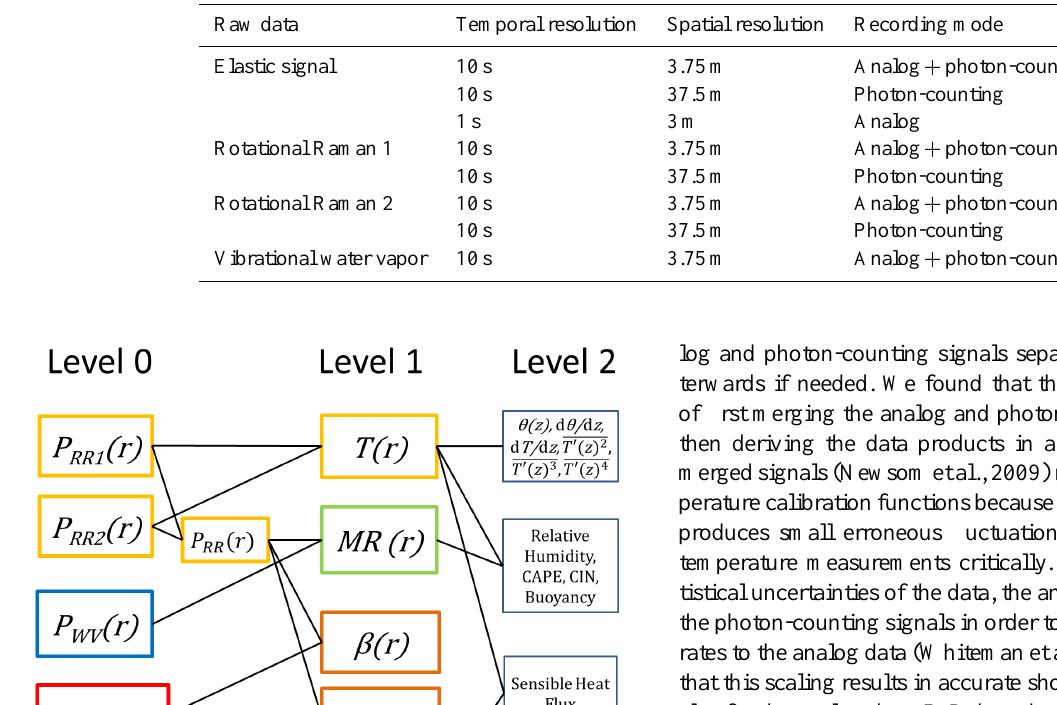
Table 2. Signal raw resolution.